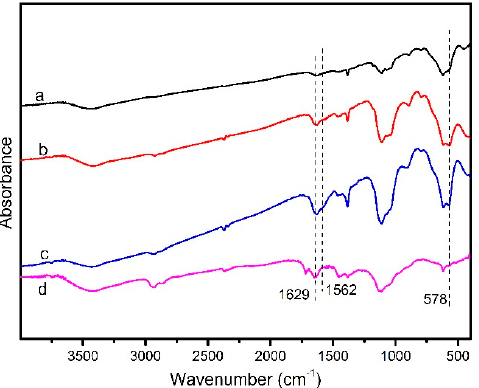
Figure 2. FTIR spectra of (a) Fe 3 O 4 ; (b) APTES–Fe 3 O 4 ; (c) magnetic CALB CLEAs; (d) CALB CLEAs.